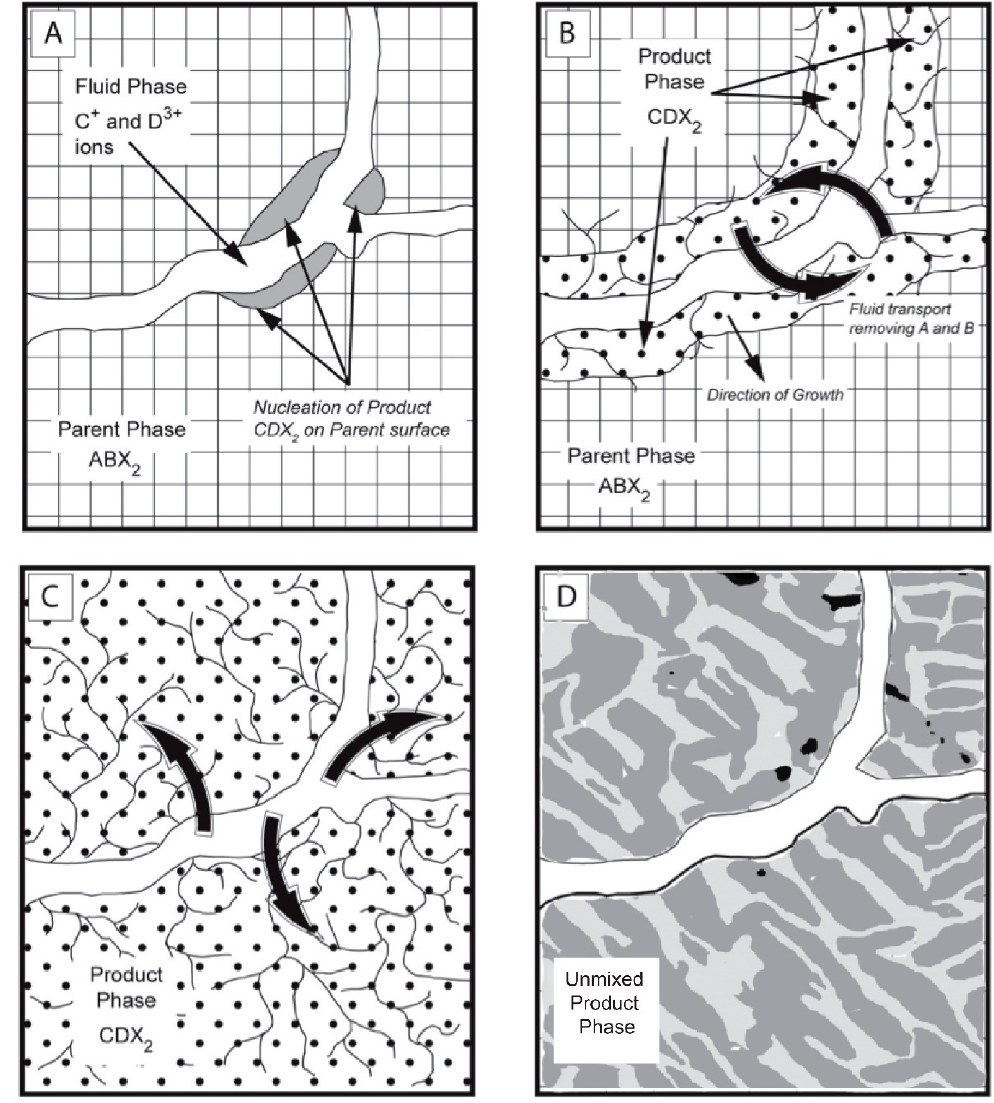
Figure 10. A diagrammatic representation of interface-coupled dissolution–reprecipitation. ( A ) Fluid containing C + and D 3+ ions goes through cracks within the parent phase of ABX 2 . ABX 2 phase dissolves at the reaction surface and CDX 2 product forms on the surface. ( B ) Fluid transports through pores and cracks to reaction interface adding C + and D 3+ . ( C ) Curved arrows show direction of fluid flow. ( D ) Porosity anneals out over time and fluid inclusions form from the solution trapped within the crystal. Unstable product phase of CDX 2 exsolves into two new phases upon quenching, catalyzed by the fluid within the porosity and along the grain boundaries.